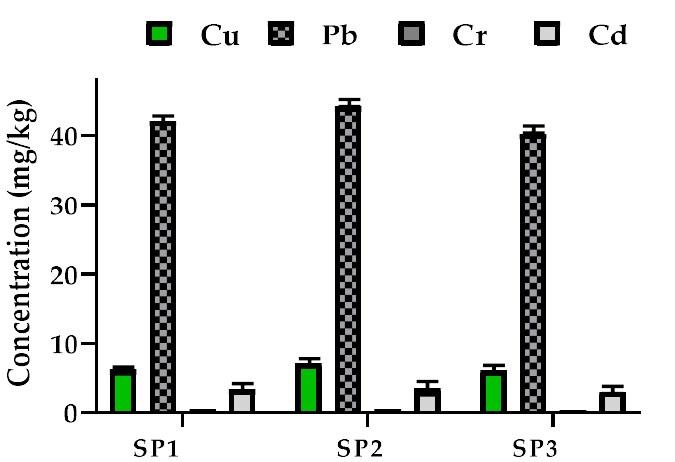
Figure 3. Mean concentration of HMs in sediments from Port Bell, Northern L. Victoria, Uganda. Error bars represent standard deviations of analyses that were performed in triplicate (n = 9).